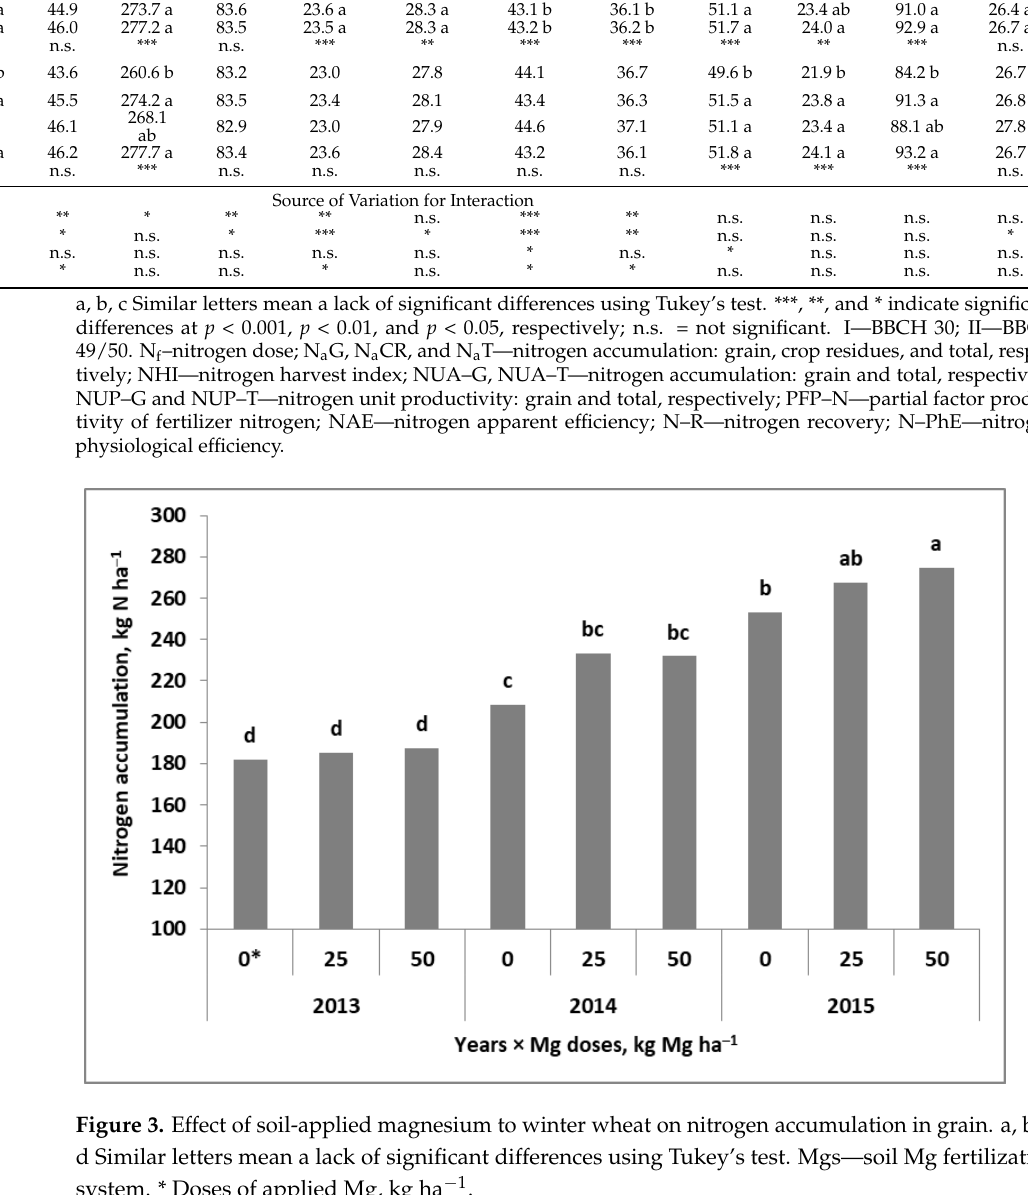
Figure 4. Effect of foliar fertilization of winter wheat with magnesium on nitrogen accumulation in grain. a, b, c, d, e Similar letters mean a lack of significant differences using Tukey’s test. Mgf— foliar Mg fertilization system. * Stages of Mg foliar fertilization to wheat: I — BBCH 30; II — BBCH 49/50. The classic NUE index, the partial factor productivity of fertilizer N (PFP – N f ), re- sponded to the Mgs × Mgf interaction, and the nitrogen physiological efficiency (N-PhE) responded to the Y × Mgf interaction. The application of Mg significantly increased the productivity of N f . The differences between the Mg absolute control plot and plots ferti- lized with Mg were significant. The strongest increase in PFP-N f was recorded for Mgs50, which provided double- foliar fertilization with Mg. The highest variability in N‒PhE in- dices was recorded in 2013 (Figure 6). Nitrogen utilization by wheat increased in response to Mg foliar fertilization, peaking when applied at BBCH 49/50. In the remaining two